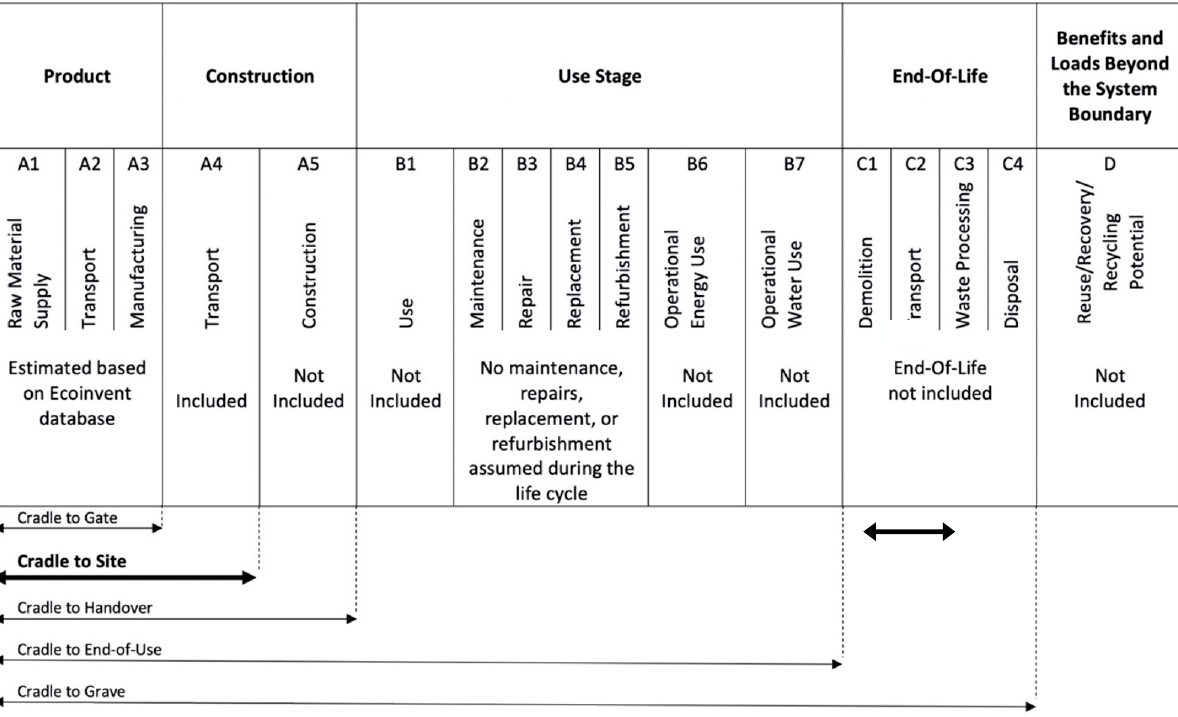
Figure 4. System boundary, cradle to site, of the fiberglass house LCA study. Figure according to EN 15804. Adapted from U.S. Green Building Council [41].